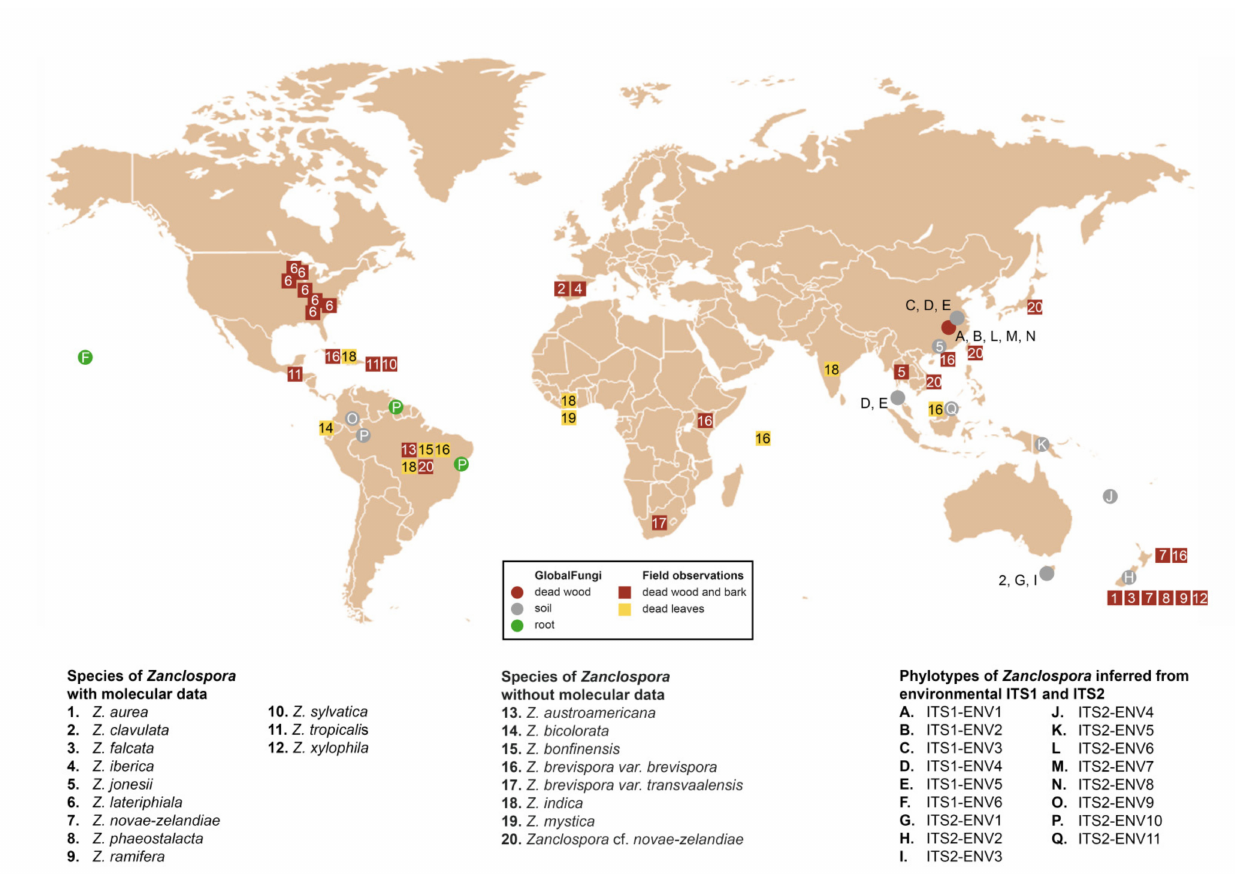
Figure 7. Geographical distribution and substrate affinity of Zanclospora species with known ITS sequence data. The map summarizes data from the GlobalFungi database (shown by circles) and field collections verified by sequencing (species 1–12) or based only on published data (species 13–20) (shown by squares). See Tables S2 and S6 for primary data. Each symbol (circle or square) represents a unique sample. The substrates are differentiated by colours. Note that environmental taxa defined by ITS1 sequences can overlap with those from the ITS2